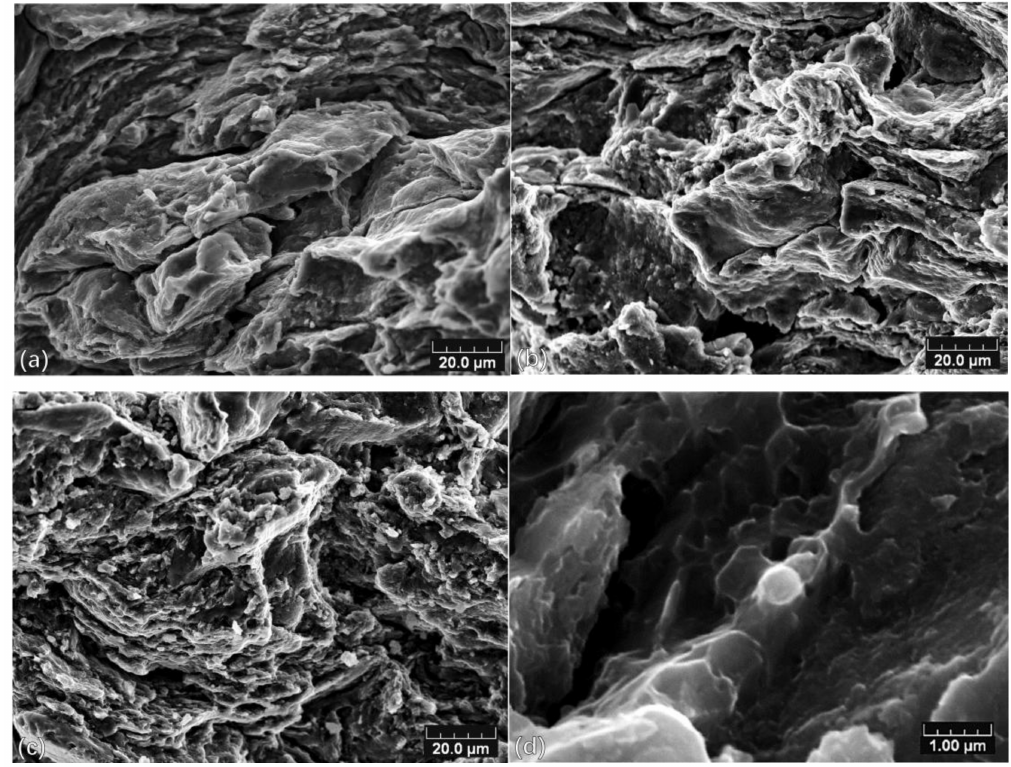
Figure 6. Fracture microstructures of AZ91D coatings elaborated at 500 ◦ C ( a ), 550 ◦ C ( b ), 600 ◦ C ( c ); and partial enlarged drawing in b ( d